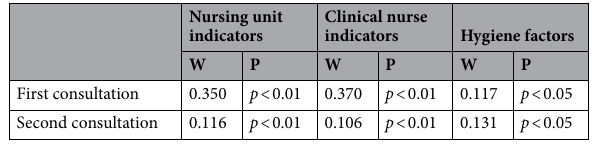
Table 2. Coordination and